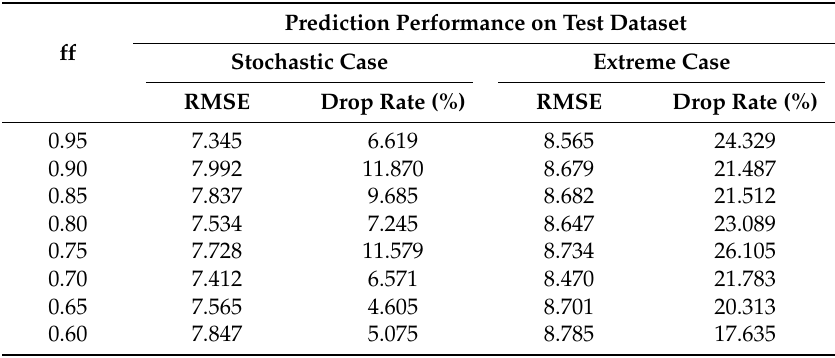
Table 6. Prediction results in the case of stochastic and extreme